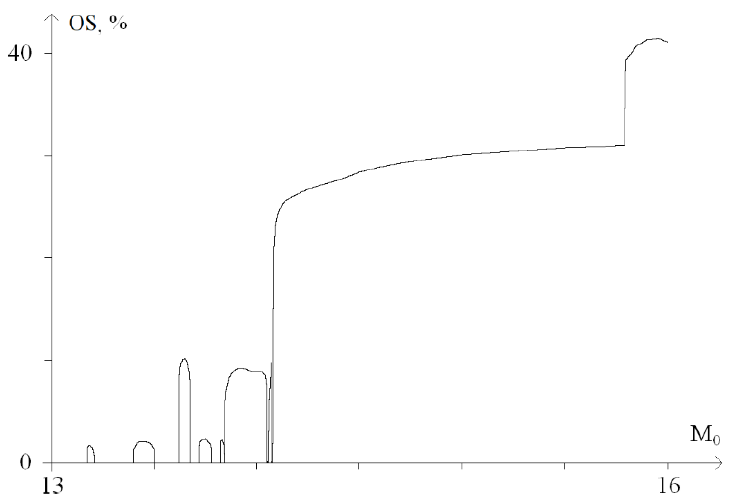
Figure 6. Graph of the probability (in percent) of OS occurrence under the influence of a constant torsion moment. torsion